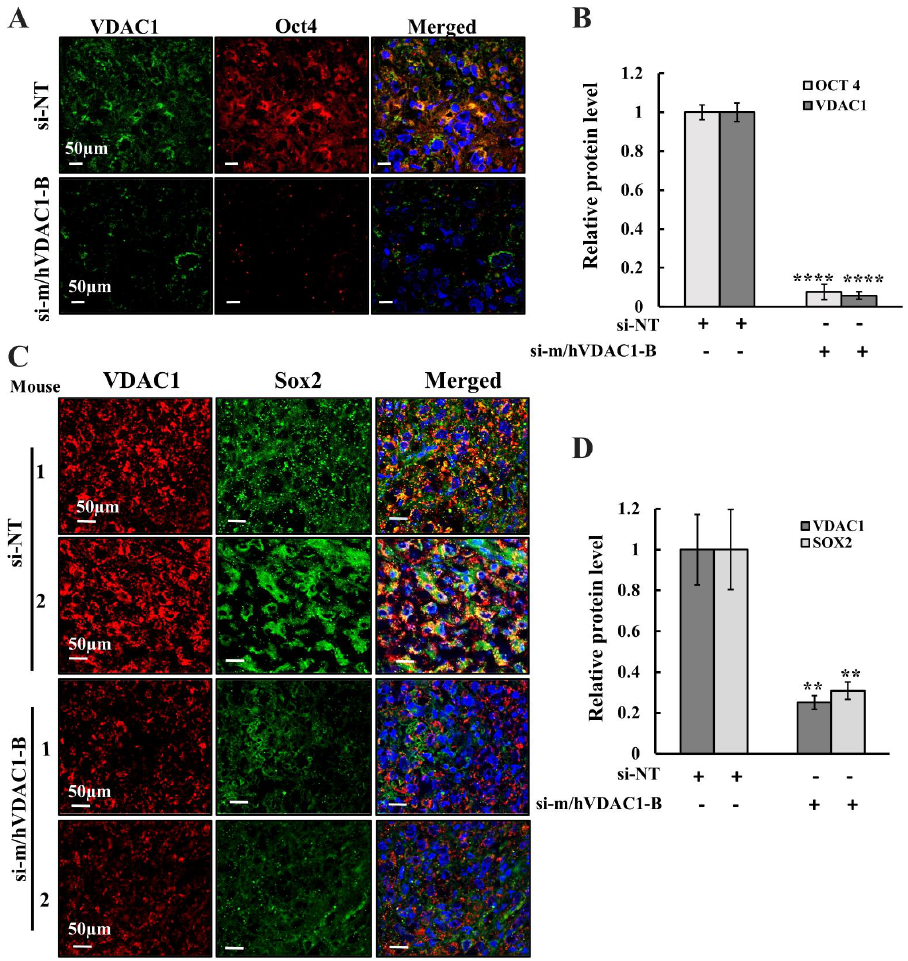
Figure 8. VDAC1 expression depletion in the tumors inhibited stemness. Representative immunofluorescence images of xenograft tumors co-immunostained for VDAC1 and Oct4 ( A ) and for VDAC1 and Sox2 ( C ), and staining intensity was quantified ( B , D ). The results are the means ± SEM, ** p ≤ 0.01; **** p ≤ 0.0001